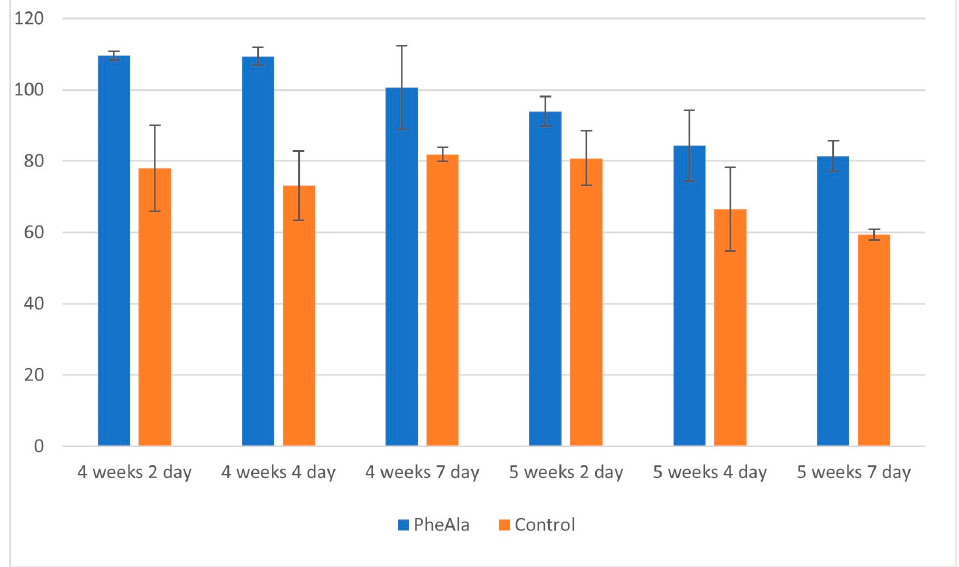
Figure 1. Total content of phenolic acids in the biomass of R. graveolens agitated shoot cultures (4- and 5-week growth cycle, time after addition of phenylalanine [PheAla]: 2, 4, and 7